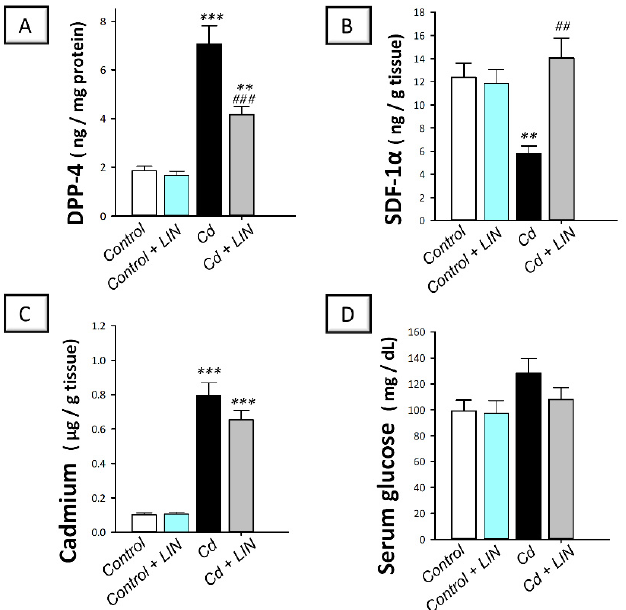
Figure 3. Effect of cadmium and/or linagliptin administration on testicular DPP ‐ 4, SDF ‐ 1 α , and cadmium metal content alongside serum glucose in rats. The co ‐ treatment with linagliptin downregulated testicular dipeptidyl peptidase 4 content (DPP ‐ 4; ( A )) and increased testicular stromal cell ‐ derived factor ‐ 1 alpha (SDF ‐ 1 α ; ( B )) without modifying testicular cadmium metal content ( C ) or serum glucose ( D ) in cadmium ‐ intoxicated rats. ** p < 0.01, and *** p < 0.001 show statistical significance compared to the group of control rats; ## p < 0.01, and ### p < 0.001 show statistical significance compared to the group of cadmium ‐ intoxicated rats. Values are stated as the mean ± standard error of the mean for 6 animals per group. LIN, linagliptin; Cd, cadmium chloride.